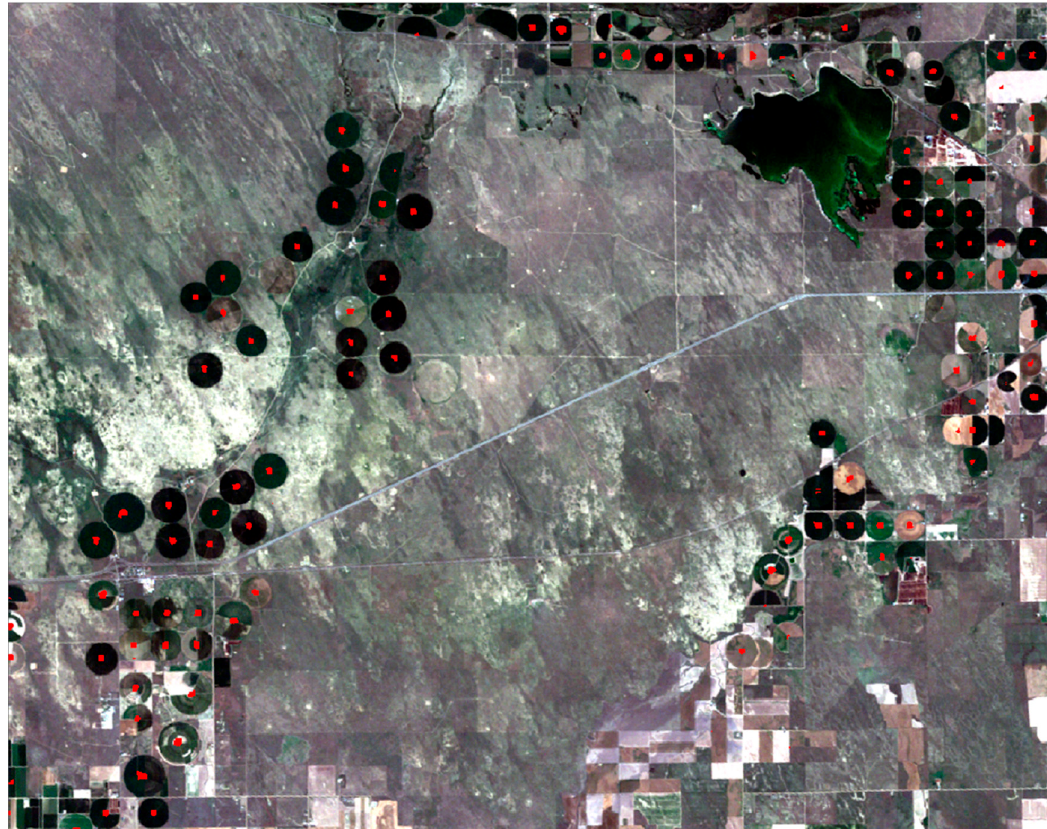
Figure 12. Images processed after the classification. Pixels that are identified as center pivot irrigation systems are displayed in red dots.